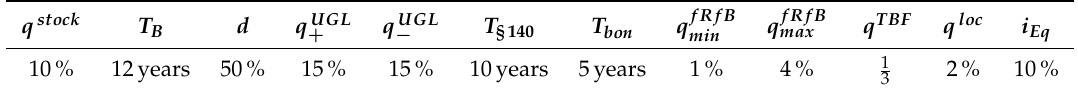
Table 5. Parameters for management rules.